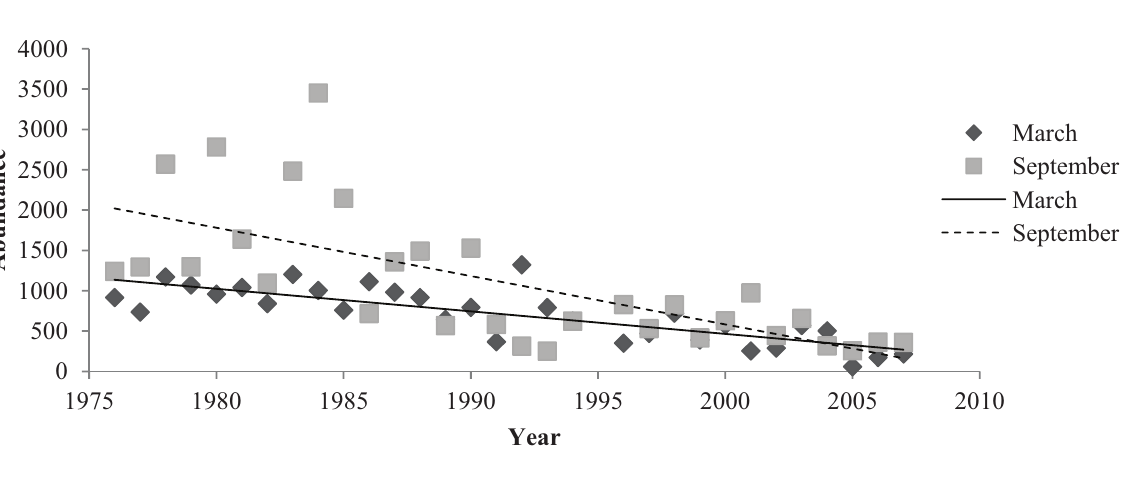
Figure 6. The abundance of introduced birds in March and September months in the Adelaide City parklands from 1976 to